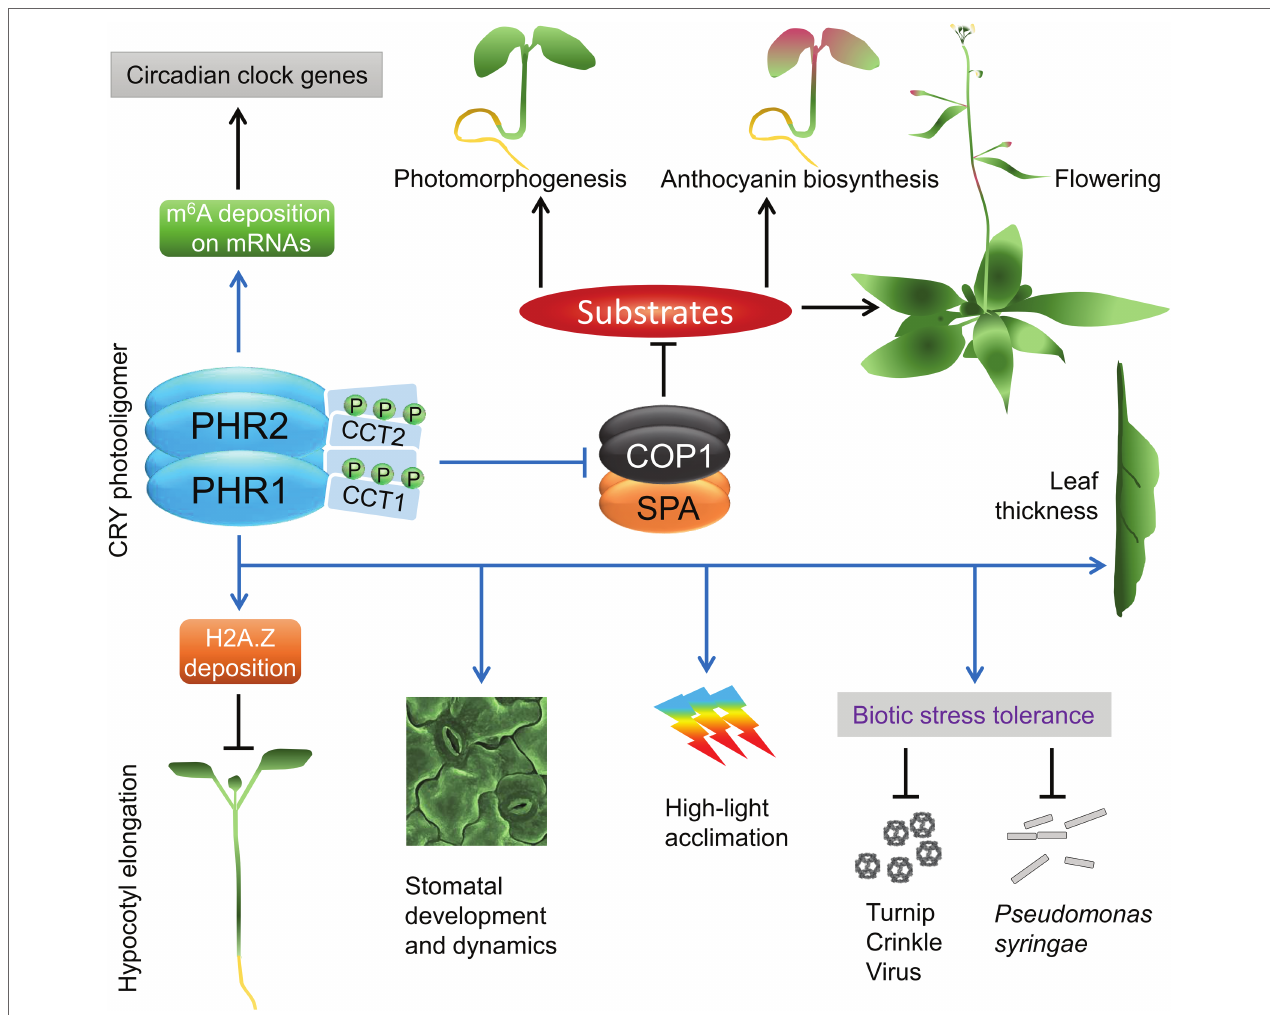
FIGURE 1 | An overview of cryptochrome signaling in Arabidopsis. Blue lines and arrows represent the direct involvement of CRYs. Abbreviations: PHR, photolyase homology region; CCT, CRY carboxy terminus; COP1, CONSTITUTIVE PHOTOMORPHOGENIC 1; SPA, SUPPRESSOR OF PHYA-105 1; m 6 A, methylation of N6 adenosine; H2A.Z, a variant of histone